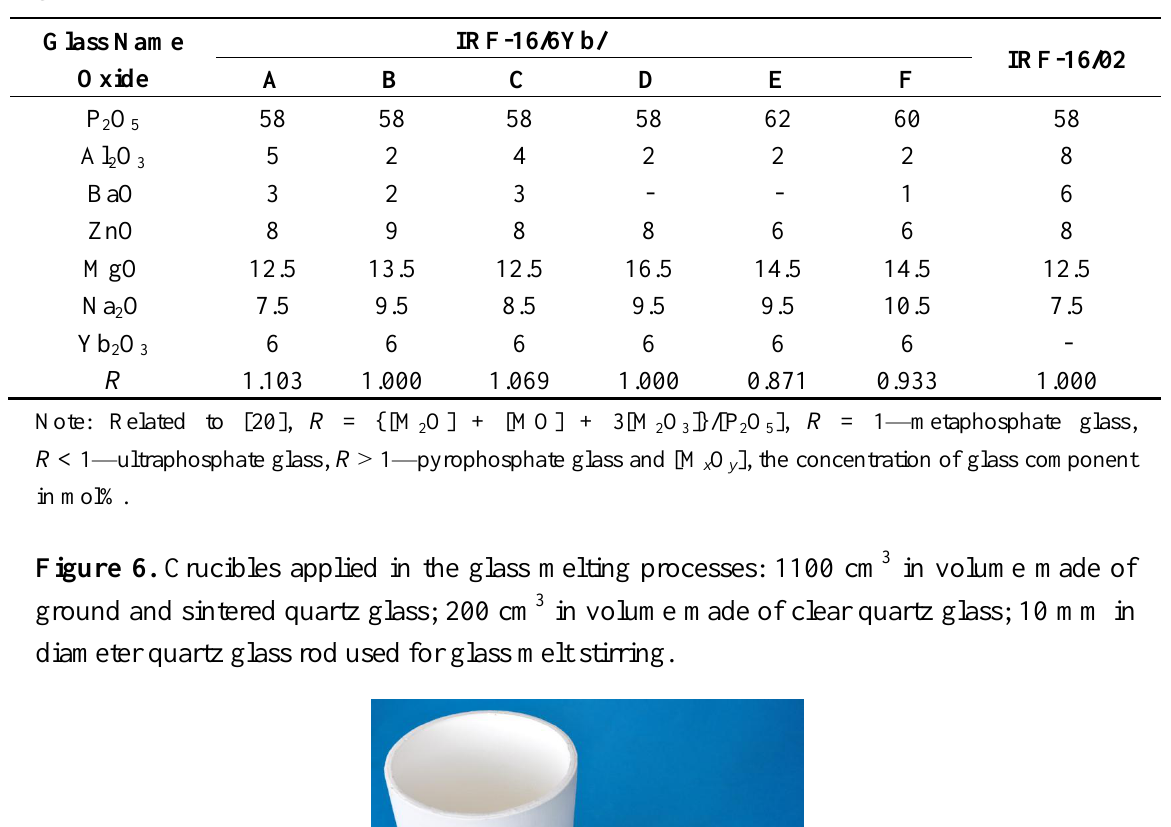
Table 4. Chemical composition of the IRF-16/6Yb/A-F series glasses and IRF-16/02 glass (mol %).